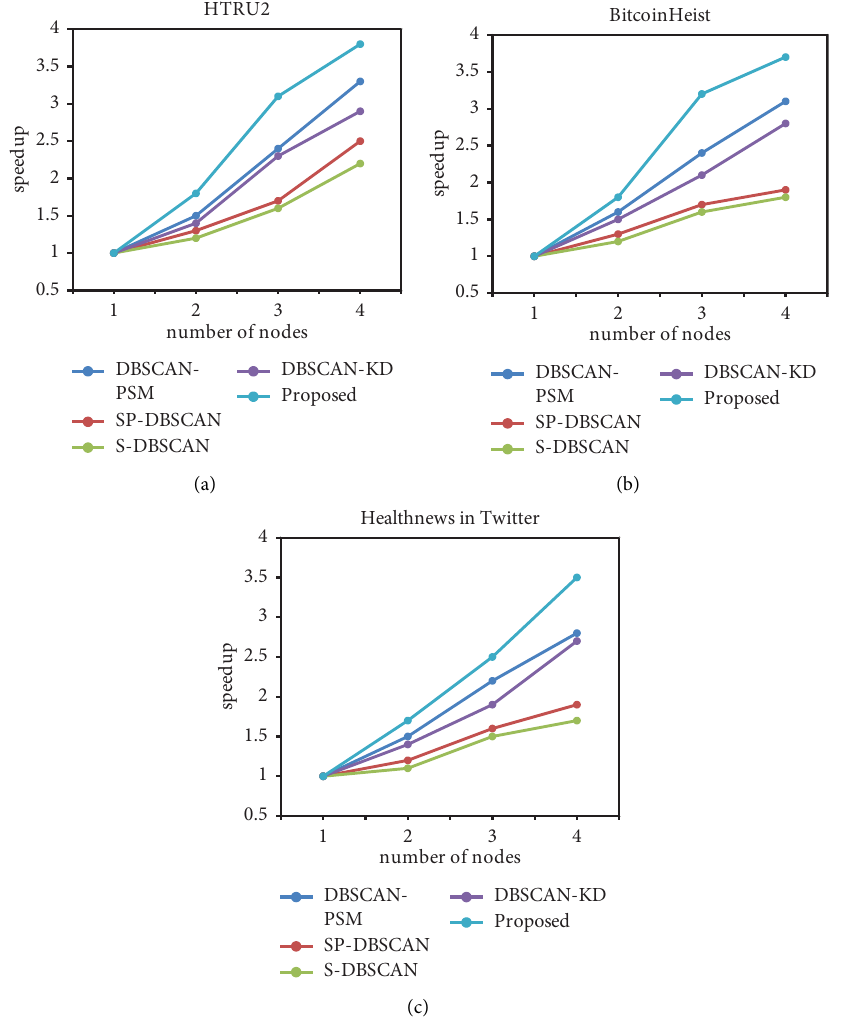
Figure 11: Comparison of acceleration ratios of diferent algorithms. (a) HTRU2. (b) BitcoinHeist. (c) Healthnews in